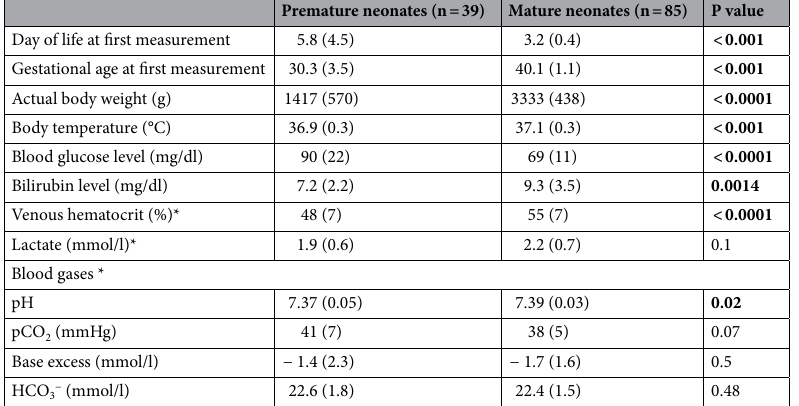
Table 2. Clinical and laboratory data of premature and mature neonates at first measurement. *values of venous samples only: preterm n = 29, term n = 43. Data are presented as mean (SD). Statistical analysis was performed with t-test or Mann–Whitney-U test. Statistically significant results are marked in bold.